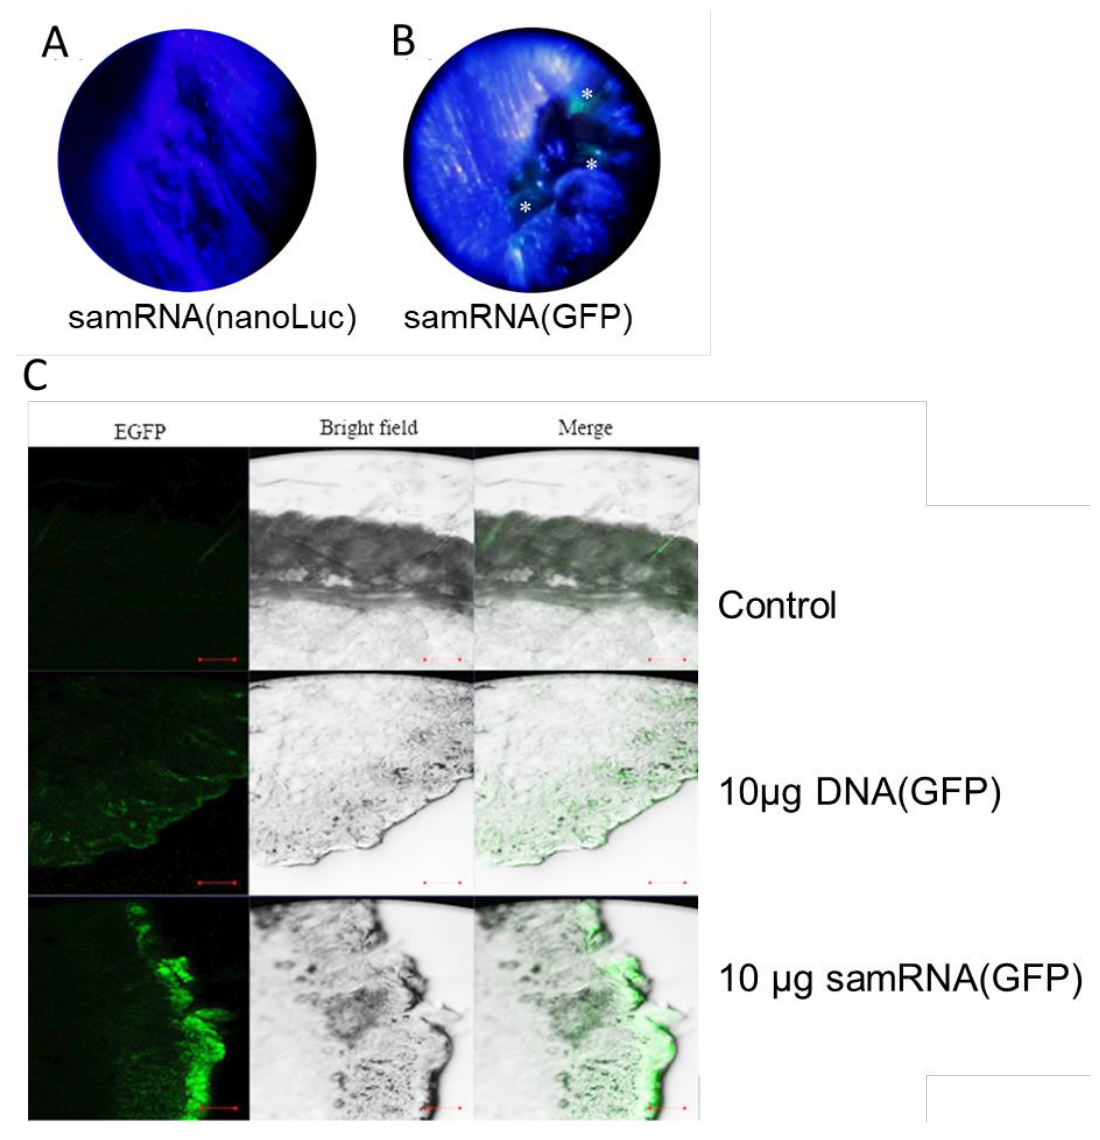
Figure 6. Stronger GFP expression was observed after tattooing samRNA compared with plasmid DNA. Comparison of tattoo scars of animals immunized with nLuc expressing replicon ( A , negative control) and GFP-expressing replicon ( B ), respectively, in cationic liposomes, observed under black light. Asterisks depict green spots on the skin of the animal tattooed with GFP replicons 48 h after the intradermal inoculation. Histological analyses of tissue sections ( C ) of BALB/c mice tattooed with liposomes encapsulating either 10 µ g of DNA plasmid or RNA-replicon-encoding GFP 48 h after inoculation in the dermis. Control mice were not tattooed, and fluorescence in the control mice is due to hair in the tissue section. Images were acquired by confocal laser scanning microscopy. Data scales of 100 µ